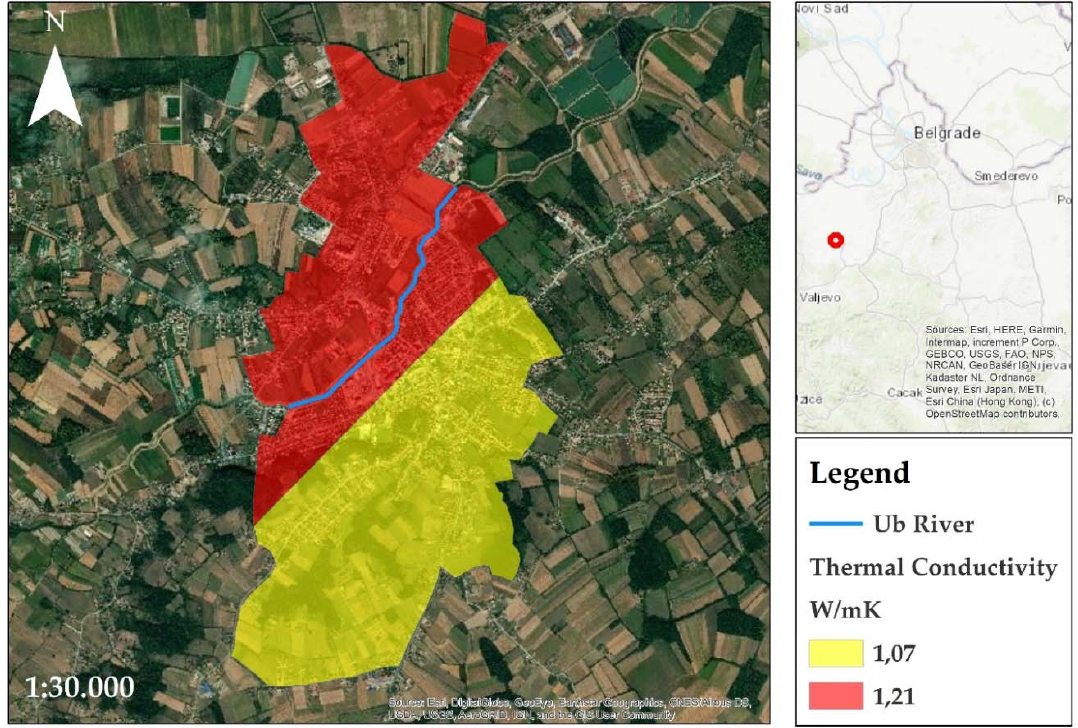
Figure 5. Very shallow geothermal potentials in the urban area of Ub (own map based on ThermoMap ).